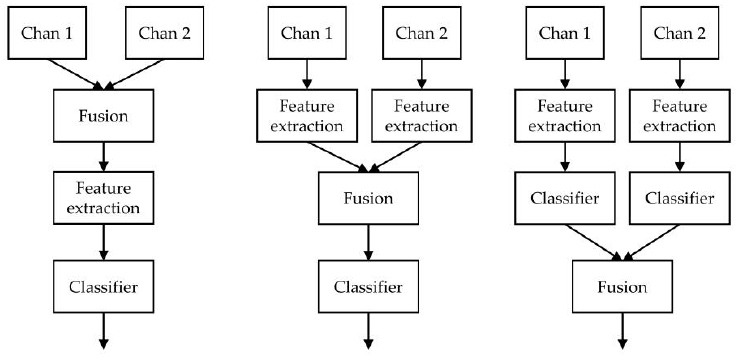
Figure 2. Diagrams of different channel fusion methods, which from left to right are data fusion, feature fusion, and decision fusion, respectively.